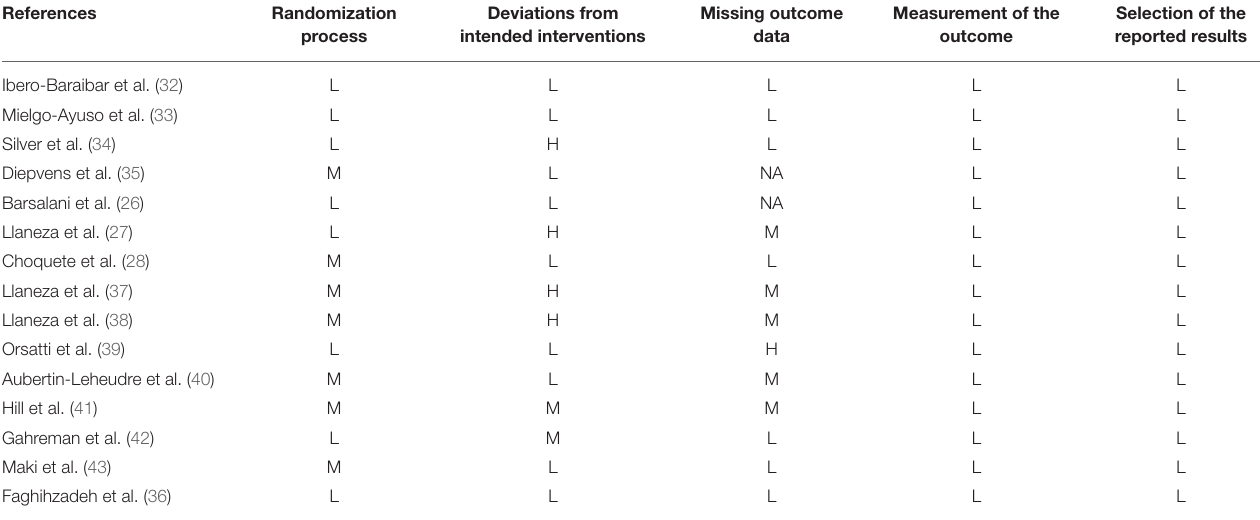
TABLE 5 | Risk of bias in the included